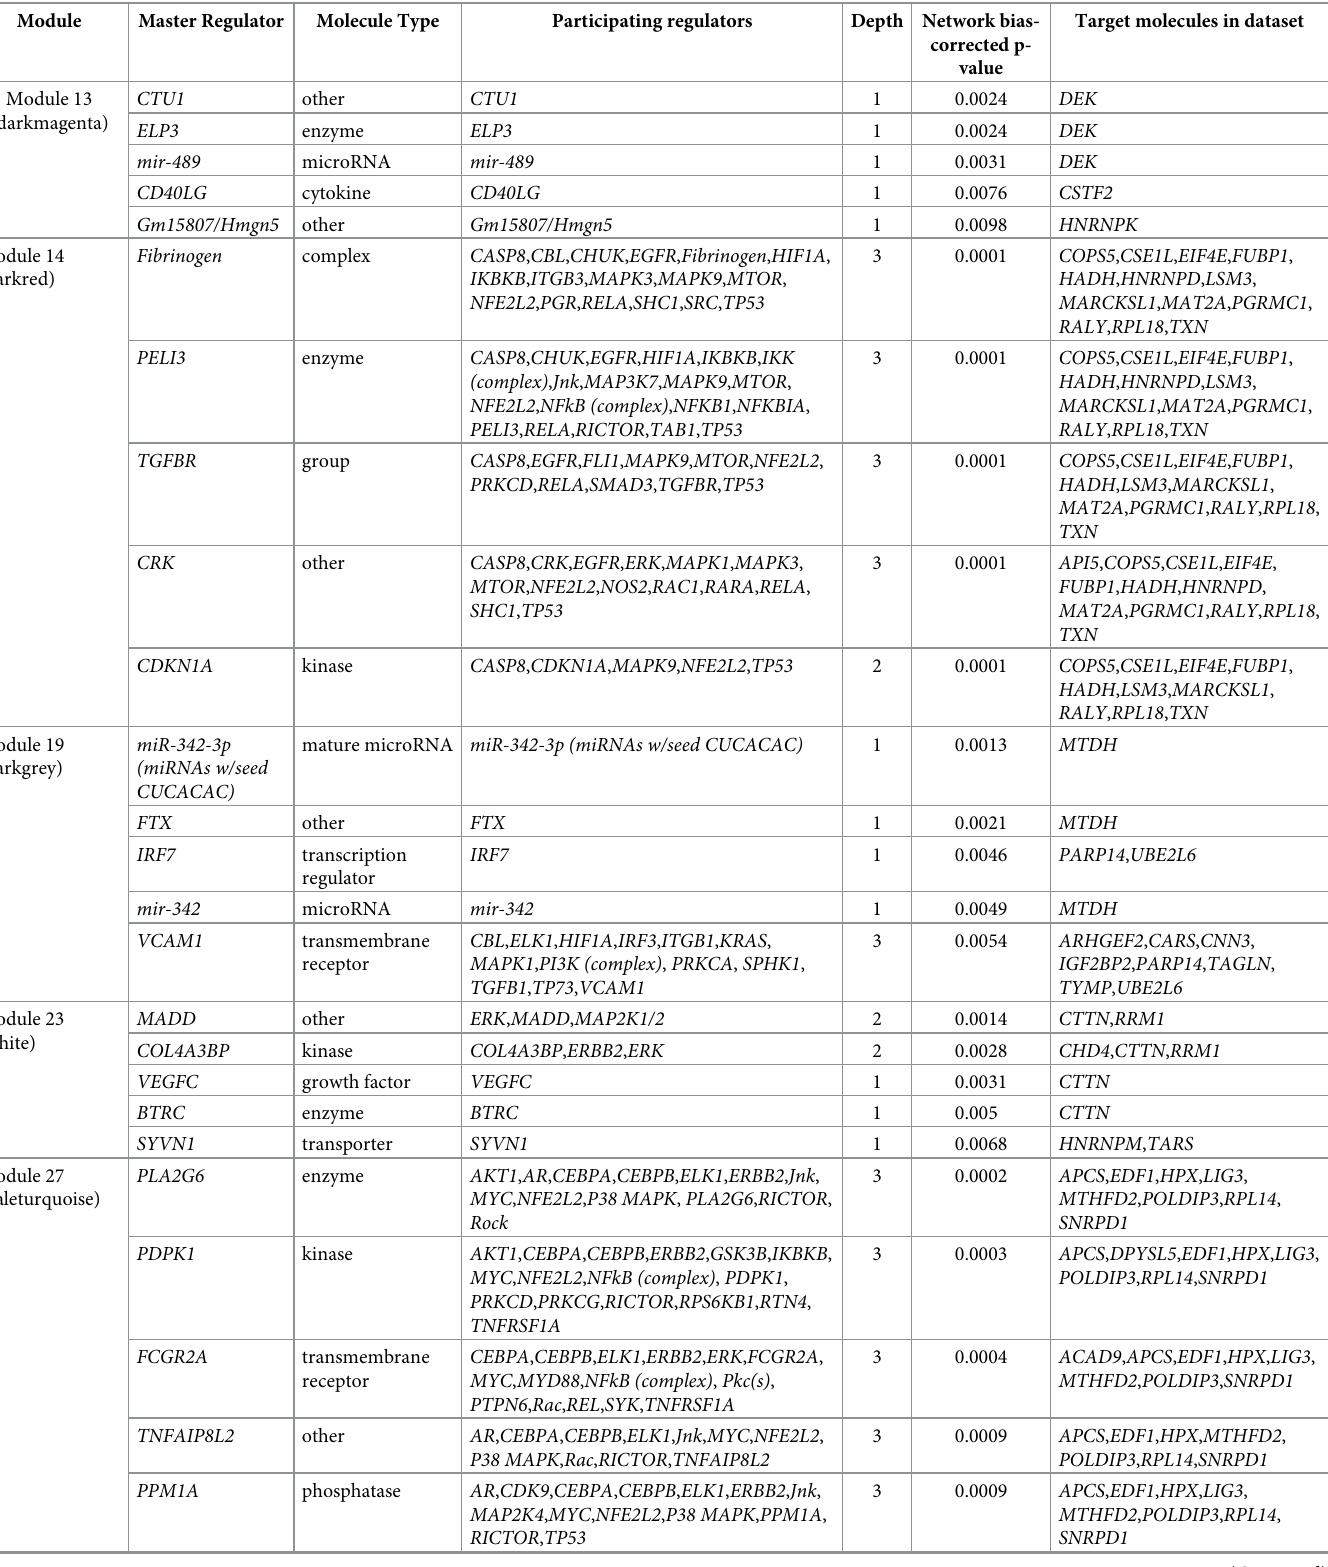
Table 2. Top 5 master regulators of selected modules predicted by causal network analysis using ingenuity pathway analysis (IPA).